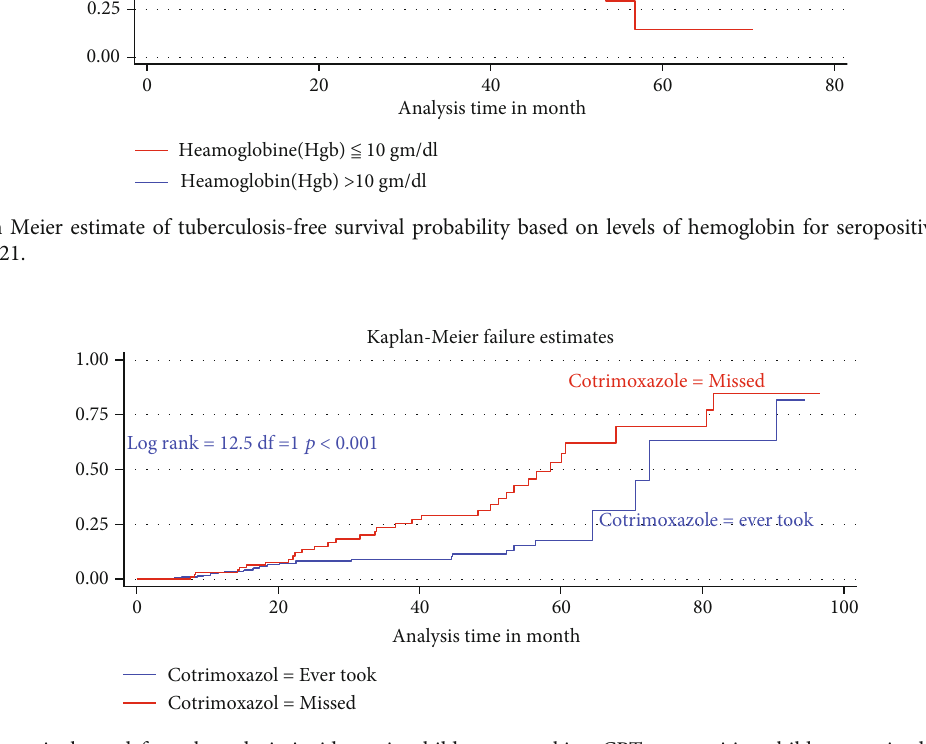
Figure 5: Di ff erence in hazard for tuberculosis incidence in children not taking CPT seropositive children received ART care in two hospitals North West Ethiopia